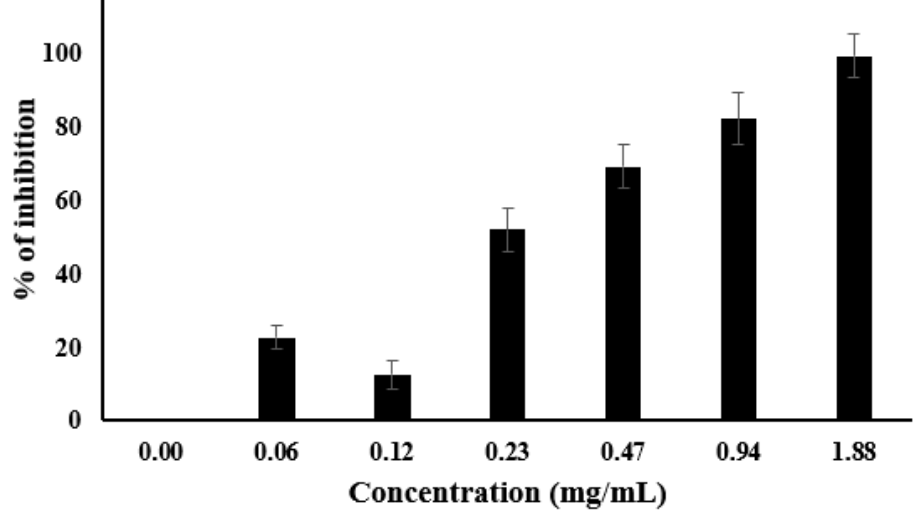
Figure 4. Effects of different OEO concentrations (mg/mL) on S. liquefaciens MDK3 growth on TSB medium.